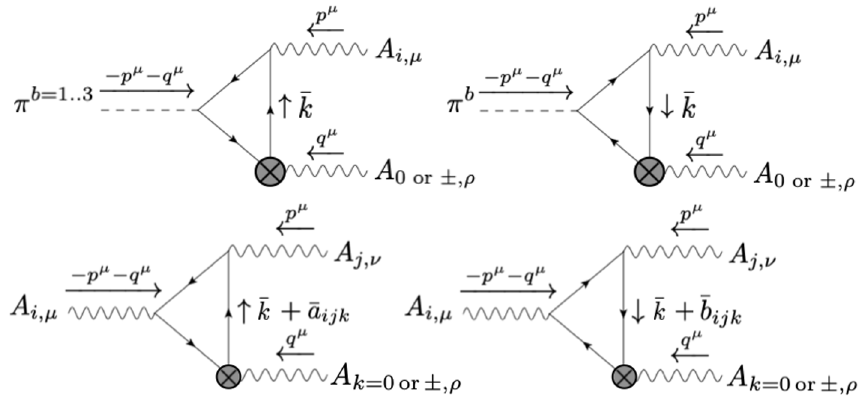
Figure 5 . Triangle diagrams leading to anomalous EFT terms. A black circled cross indicates a dimension-six EFT coupling. The vectors ¯ a and ¯ b correspond to shift ambiguities of the loop momentum ¯ k inherent to the second kind of